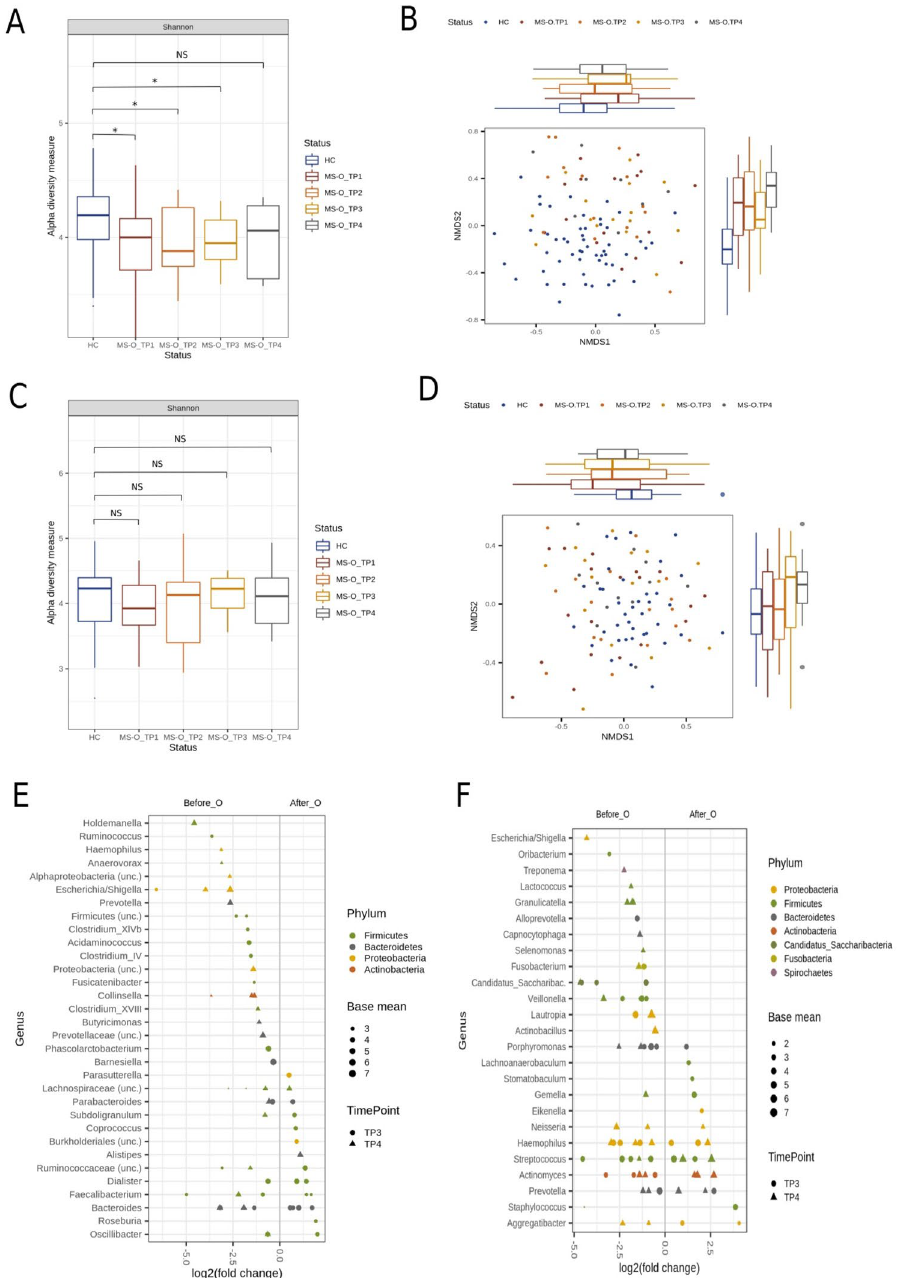
Figure 3. Microbial changes in the stool and oral cavity under treatment with ocrelizumab. Alpha diversity measurements (by Shannon) for MS-O patients showed a slight, but not significant, increase in stool ( A ) and swab samples ( C ). Compositional changes of stool ( B ) and oral ( D ) microbiota were visualized using NMDS. Differentially abundant taxa in MS patients before and after treatment with ocrelizumab in stool ( E ) and oral swab samples ( F ) were calculated by using a generalized linear mixed model (GLMM) after 6 and 12 months. In the right parts of the plots, taxa are more abundant in MS patients before treatment and in the left parts, taxa are more abundant after treatment. Dots represent changes after 6 months, whereas triangles correspond to changes after 12 months. Dot/Triangle colors indicate phyla affiliation of shown